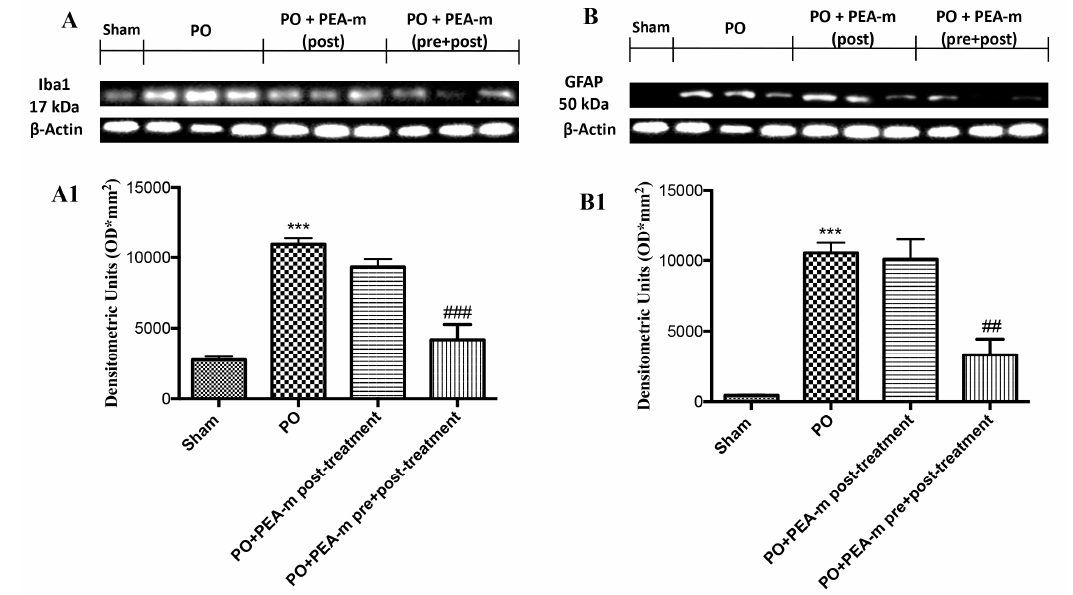
Figure 6. E ff ects of PEA-m on ionized calcium binding adaptor molecule 1 (Iba1) and glial fibrillary acidic protein (GFAP) expression after PO. Representative Western blots showing the e ff ects of PEA-m on ( A , A1 ) Iba1 and ( B , B1 ) GFAP expression at 24 h after PO. PEA-m as pre + post-treatment reduced Iba1 ( A , A1 ) and GFAP ( B , B1 ) expression. A representative blot of lysates from five animals per group is shown, together with a densitometric analysis for all animals. The results in (A) and (B) are expressed as means ± SEM of five animals for each group. ( A1 ) *** p < 0.001 vs. sham; ### p < 0.001 vs. PO; ( B1 ) *** p < 0.001 vs. sham; ## p < 0.01 vs. PO.